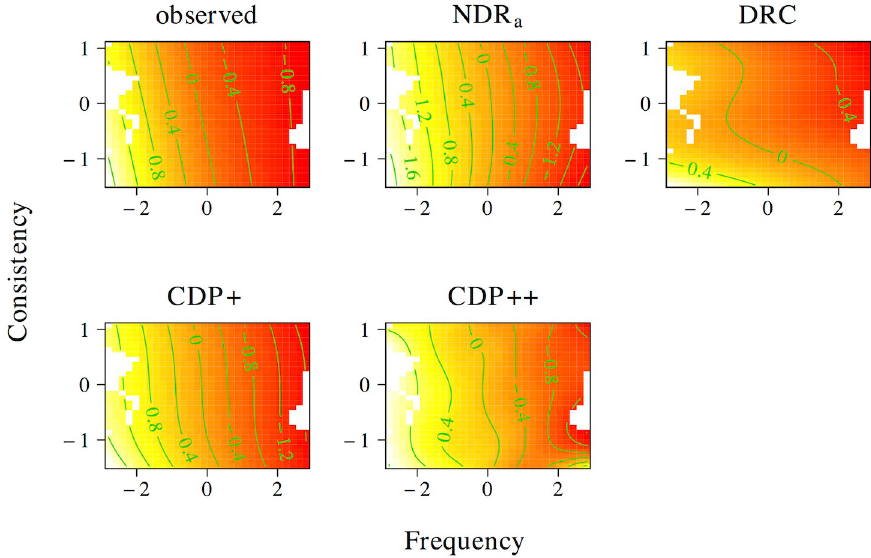
Fig 15. Interplay of frequency and consistency. The interaction of frequency with consistency in tensor product